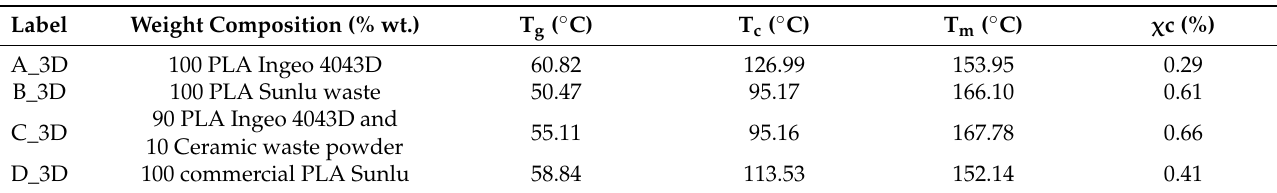
Table 4. Thermal properties of 3D bars printed and percentage of crystallinity χ c